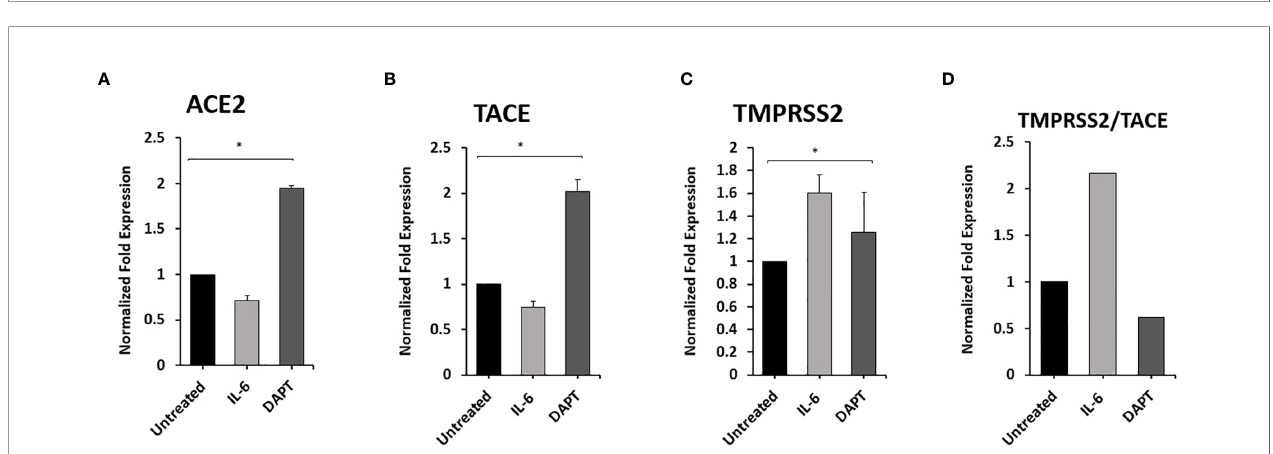
FIGURE 4 | Anti-TNF- a inhibit ACE2 and TACE expression and enhance TMPRSS2 in THP-1 derived macrophages. THP-1 derived macrophages were treated with non-PEGylated anti-TNF- a (ADA; 40 m g/ml). (A – C) The expression levels of ACE2, TACE, and TMPRSS2 were detected by RT-PCR. (D) The ratio between TMPRSS2 and TACE. All experiments were performed in triplets. Data are shown as mean ± SD, and signi fi cance is considered as *P < 0.05.